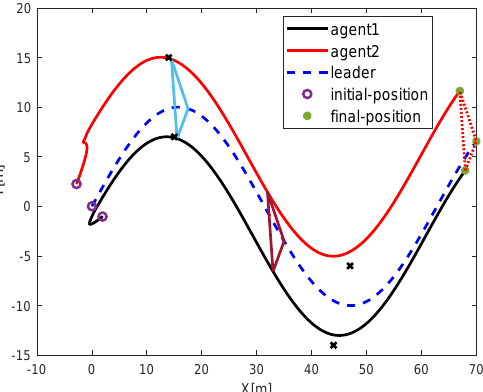
Figure 11. Formation control while considering obstacles (black cross). Trajectory obtained by using the control algorithm in reference